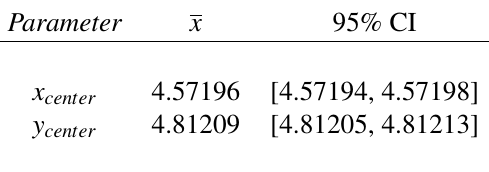
Table 1: Mean and 95% confidence intervals for the calculated 2D Gaussian peak position for 100,000 fits of a single peak